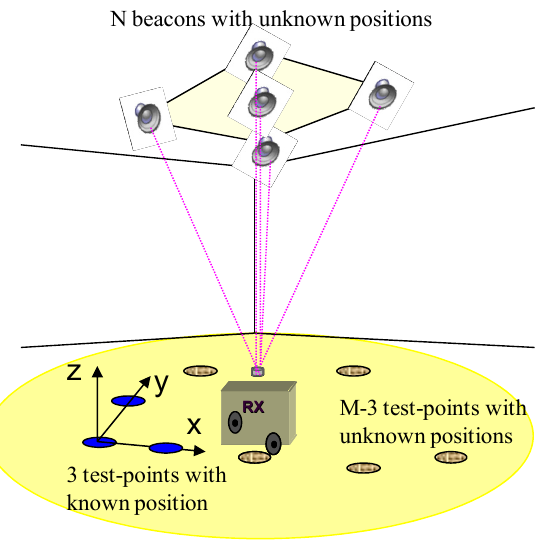
Figure 1. Representation of the LPS to be